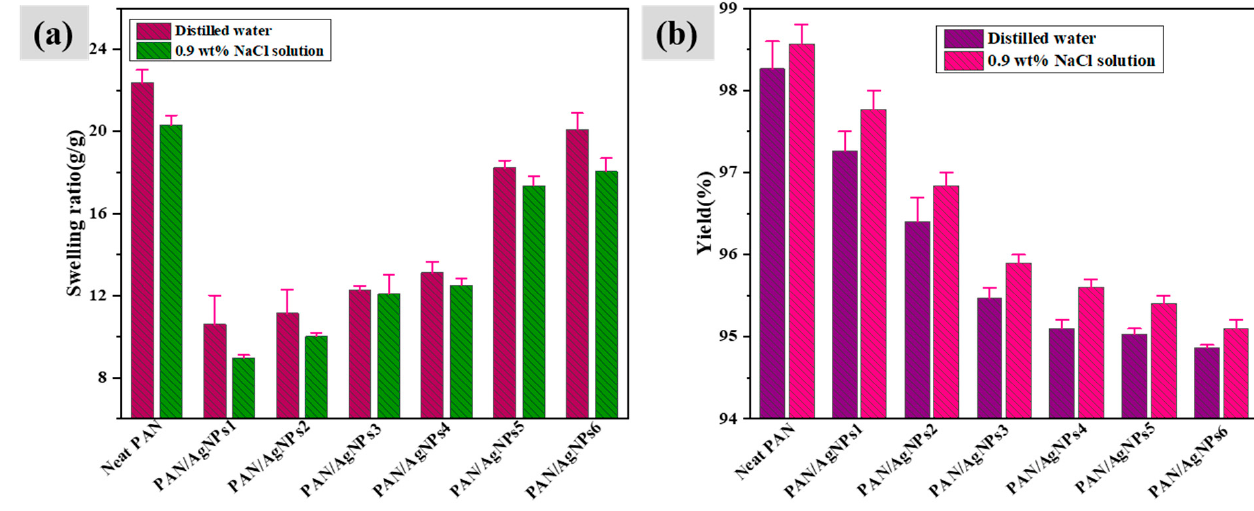
Figure 7. Swelling ratio ( a ) and Yield (%) ( b ) of PAN nanofiber, PAN/AgNPs1, PAN/AgNPs2, PAN/AgNPs3, PAN/AgNPs4, PAN/AgNPs5, and PAN/AgNPs6.